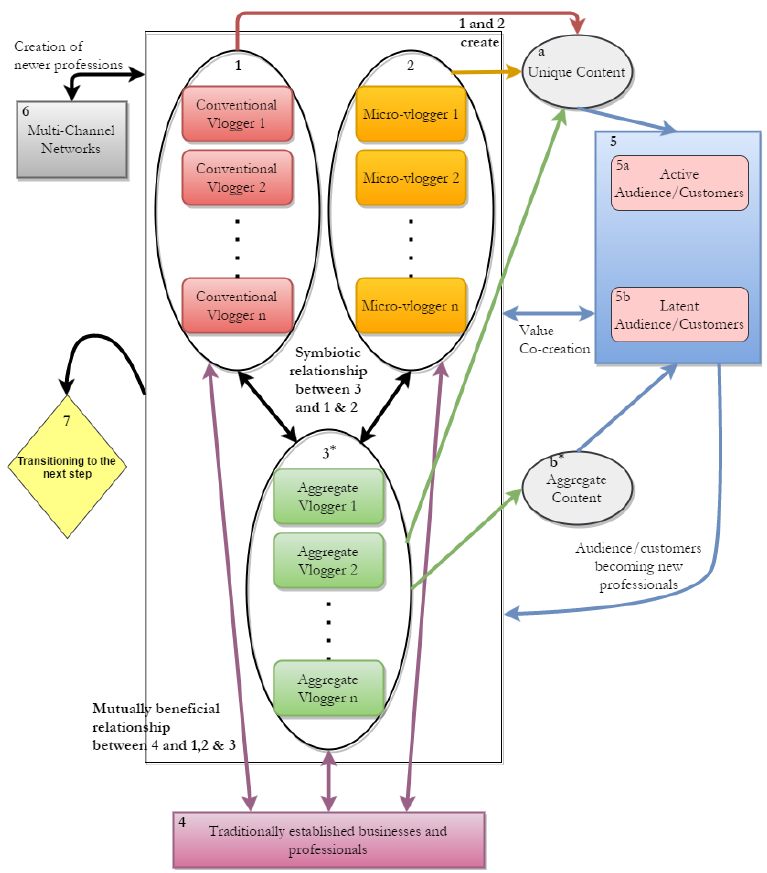
Figure 6. Value creation and co-creation interactions (vlogging).